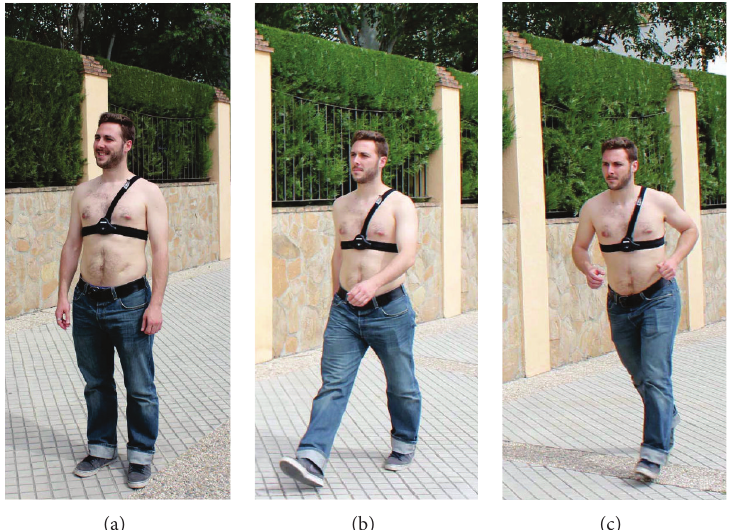
Figure 6: Examples of different intensity exercises monitored through the EQ01 sensors. User (a) standing still, (b) walking, and (c)